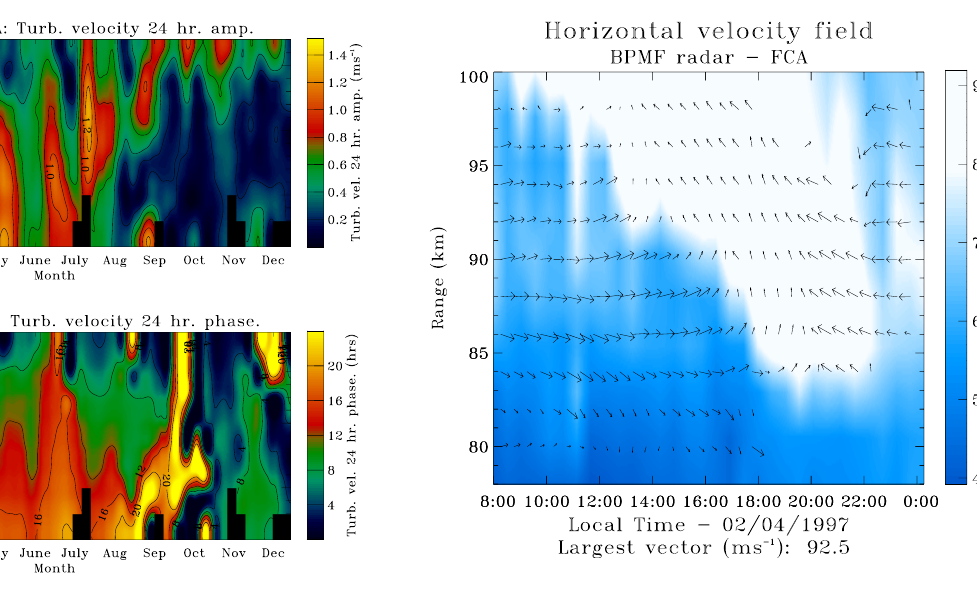
Fig. 7. Magnitude (top) and phase (bottom) of the diurnal variation Figure5. Superposedepochplotofthezonal(top)andmeridionalvelocity(bottom) of the turbulent velocity deduced by harmonic fitting. forMarch1999.